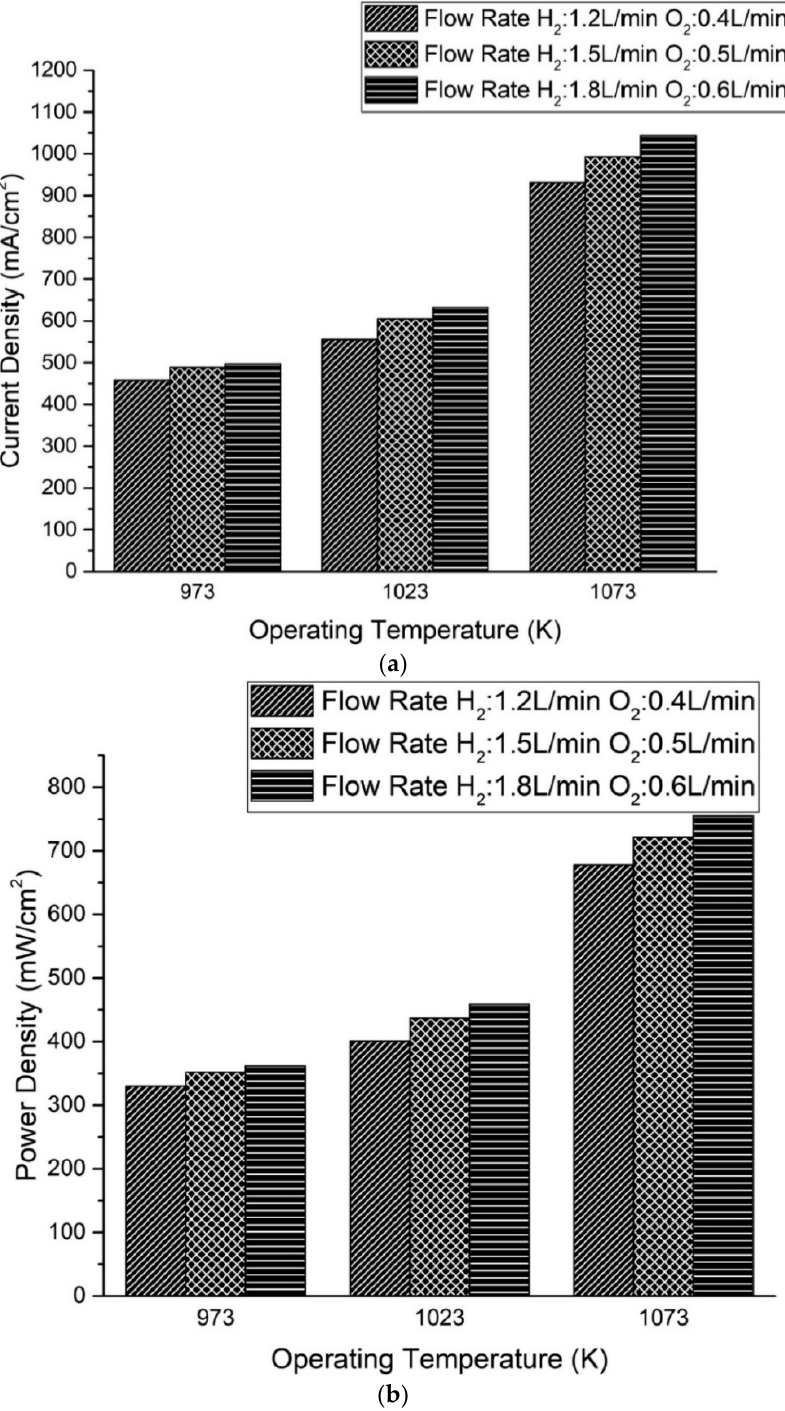
Figure 12. ( a ) current density and ( b ) power density variation with temperature and flowrates for a button SOFC (0.6 V). Reprinted with permission from Ref. [54]. Copyright 2021, Elsevier.